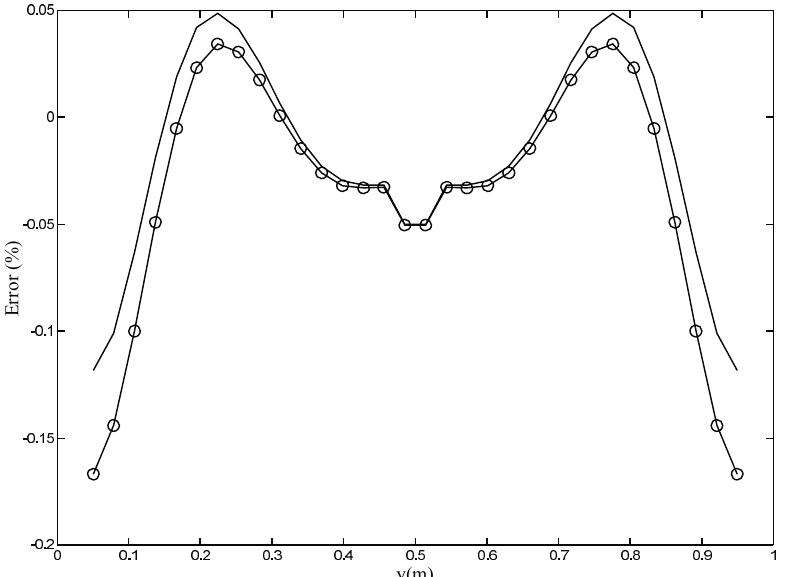
Fig. 7. Comparison of error between EFA analytic solutions and both EFBEM solutions along representative line when f = 1 kHz and η = 0 . 2 : —, direct EFBEM; (cid:3) , indirect EFBEM. As the first example, the rectangular thin plate of Fig. 4(a) applied with a transverse harmonic force is considered, and simply-supported edges can be assumed by zero energy outflow (intensity) boundary conditions as in Fig. 4(b). Then, the dimensions and thickness of the plate are L x = L y = 1 m and h = 1 mm, respectively, and the